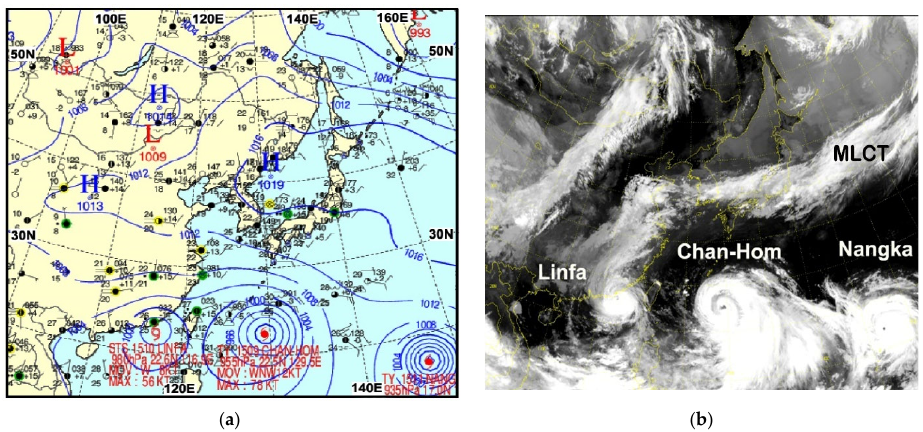
( b ) Figure 17. ( a ) Images taken at 09:00 LST, 8 July 2015, and ( b ) 09:00 LST, 9 July. Long black area oriented from southwest to northeast in ( a , b ) indicates the MLCT. STS Linfa moved to the warmest sea of 31 °C SST in the South China Sea passing Luzon Island in ( a , b ). TY Chan ‐ Hom also moved over the Kuroshio current of 31 °C SST to the northeast of the Philippines, being closer to the MLCT. At 06:00 UTC, 9 July, Linfa had further intensified with central pressure down to 980 hPa as it moved westward at 13 km/h toward Macao with a maximum surface wind speed of 29 m/s. At 09:00 LST, TY Chan ‐ Hom had intensified to a central pressure of 955 hPa and a maximum wind speed of 40 m/s, owing to its now close proximity to TY